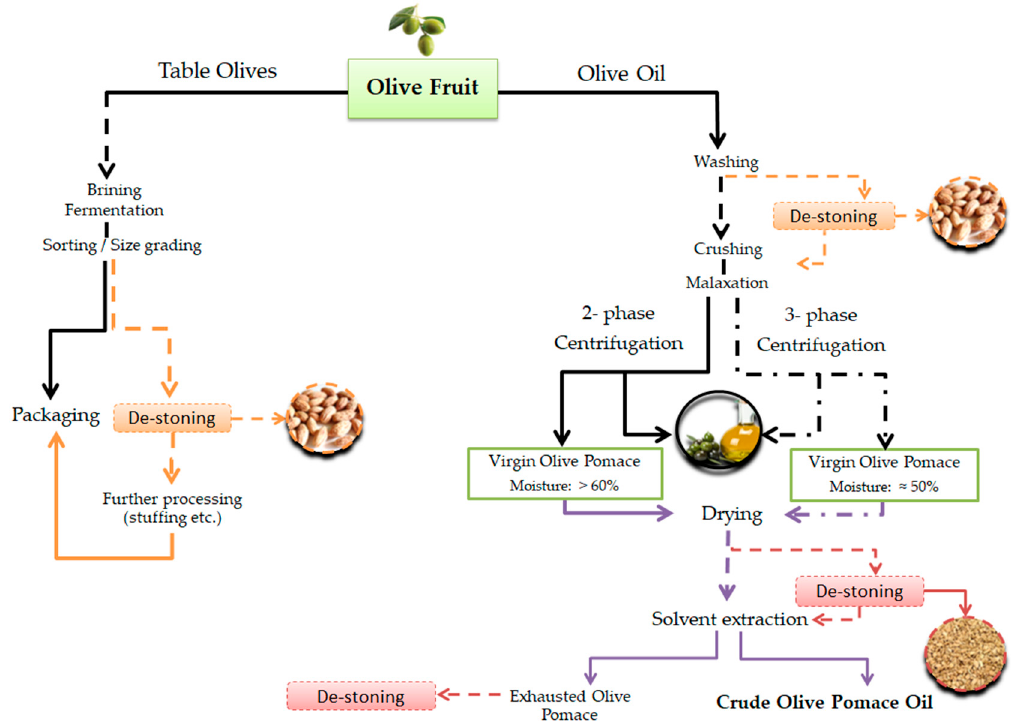
Figure 2. General processing lines for table olive, olive oil and olive pomace oil production with emphasis on the stages that generate olive stone and seed wastes [9,24].